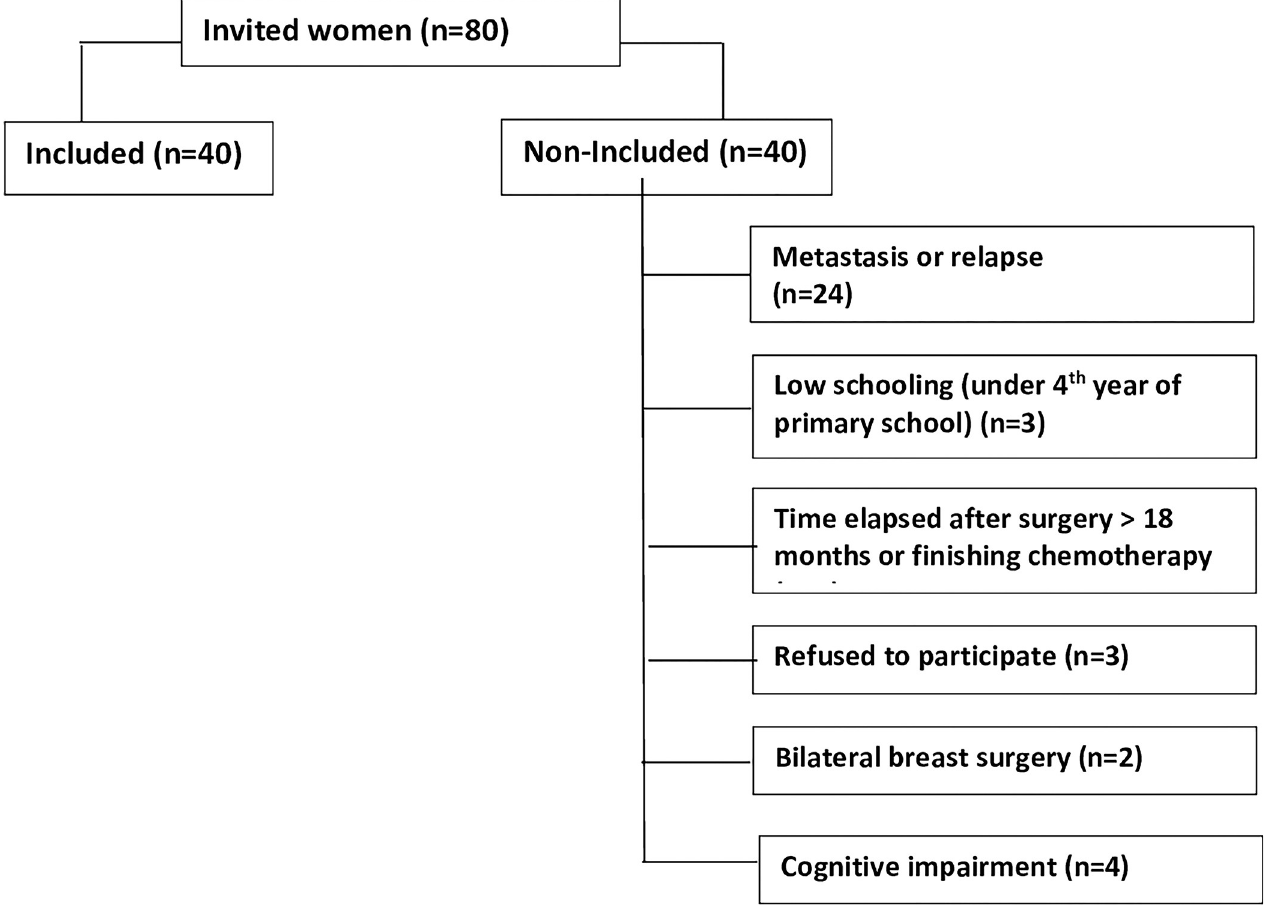
Fig 1. Recruiting